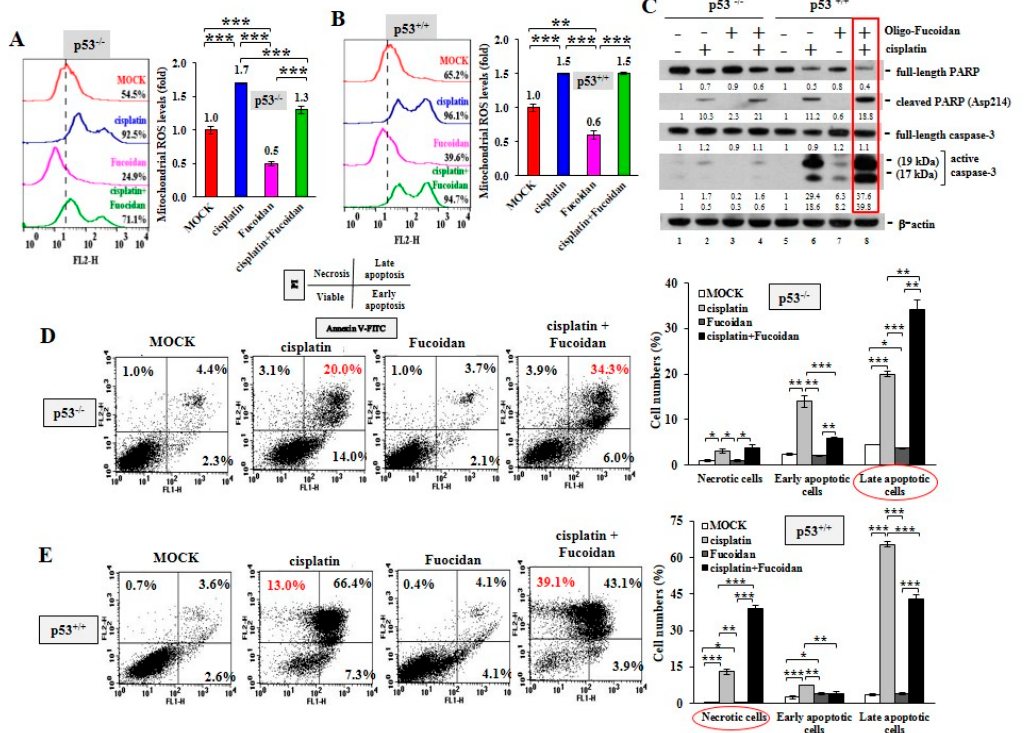
Figure 4. Oligo-Fucoidan and cisplatin together advance HCT116 cancer cell death. HCT116